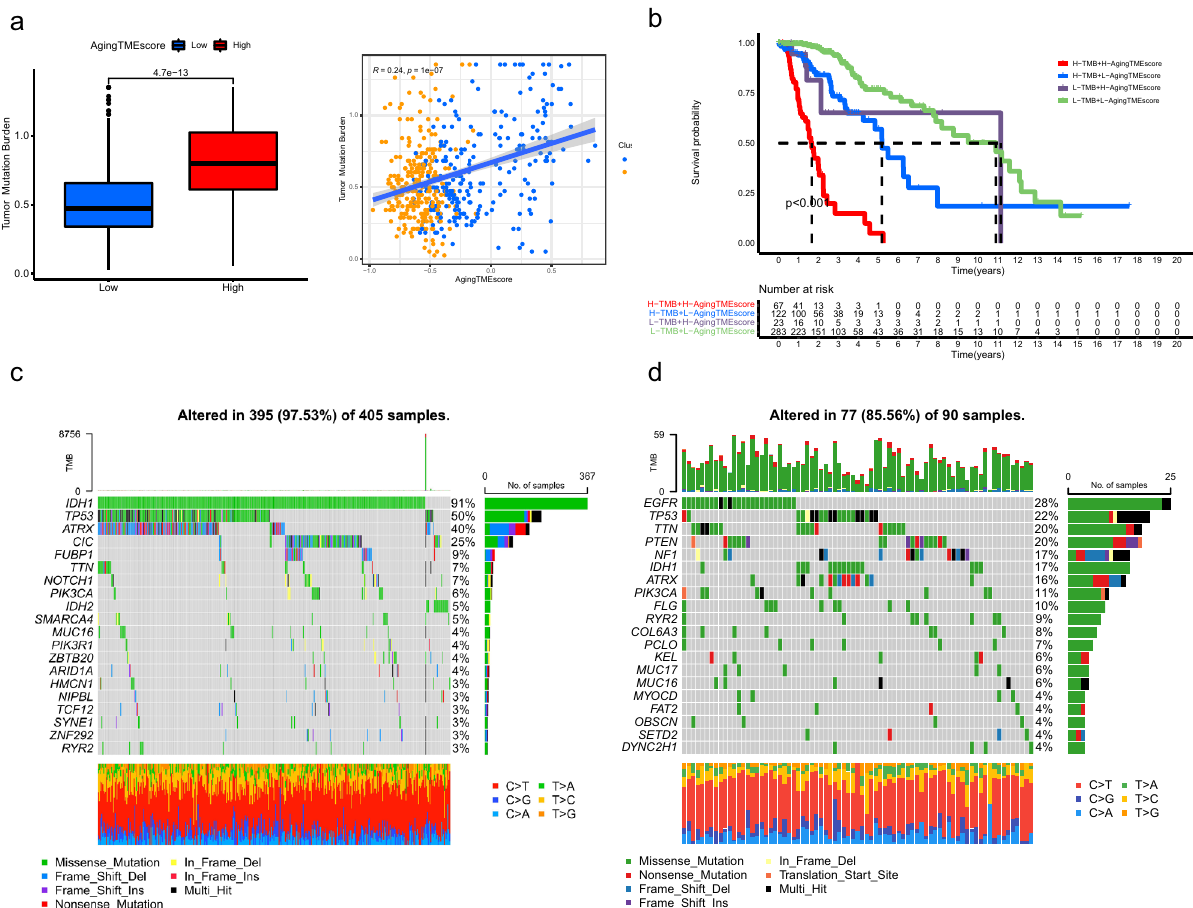
Figure 7. Somatic mutation analysis between the low and high aging TME score groups. ( a ) Correlation analysis between aging TME score and TMB. ( b ) Kaplan–Meier survival analysis of aging TME score and TMB. ( c , d ) Top 20 mutated genes in the low ( c ) and high ( d ) aging TME score groups. TME, tumor microenvironment; TMB, tumor mutation